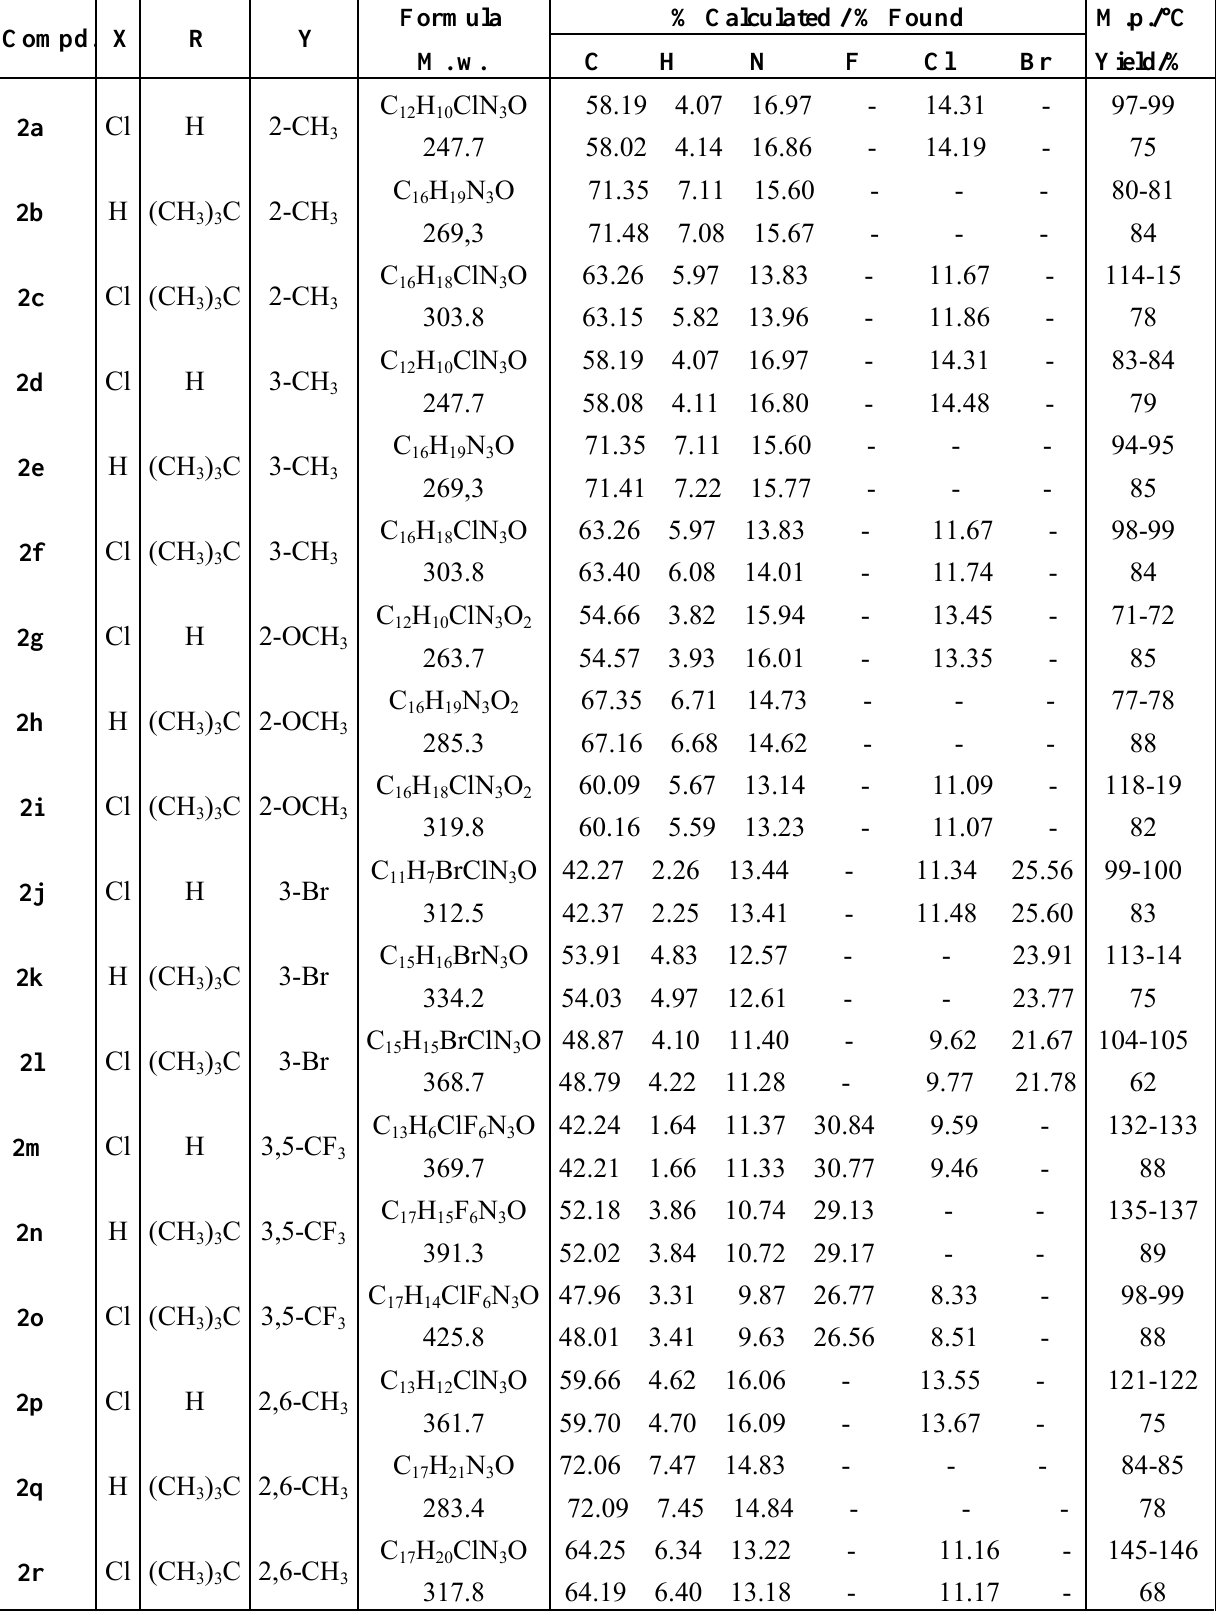
Table 3. Analytical data of the amides 2a-r